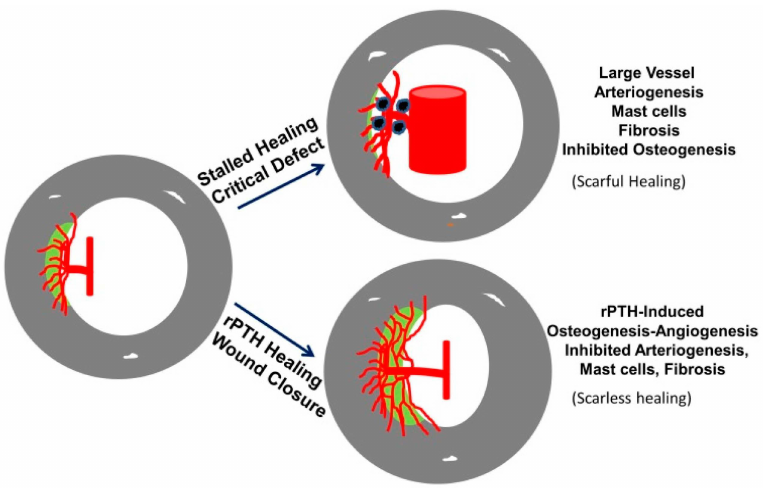
Figure 2. Schematic Model of Scarful vs. Scarless Healing and the Adjuvant Effects of rPTH Therapy. An emerging model to explain the fundamental basis of a non-healing critical defect in bone posits that there is a temporal-spatial competition between coupled small vessel angiogenesis-osteogenesis at the leading edge of the healing defect, and large vessel arteriogenesis-fibrosis within the defect. In the first two weeks after injury small vessel (<10 mm) angiogenesis facilitates rapid defect filling (scarless healing) from the leading edge (~0.02 mm/day) via proliferating/migrating bone forming osteoblasts (green). Simultaneously, large vessel (>30 mm) arteriogenesis occurs with the appearance of pro-fibrotic mast cells (dark blue) in the center of the defect, which completely inhibits osteoblastic defect filling (0 mm/day) thereafter, resulting in “scarful healing” of the critical defect. Moreover, rPTH therapy facilitates critical defect healing by: (1) its well-known anabolic effects on osteogenic cells to increase defect filling at the healing front; (2) coupled osteogenic cell-induced small vessel